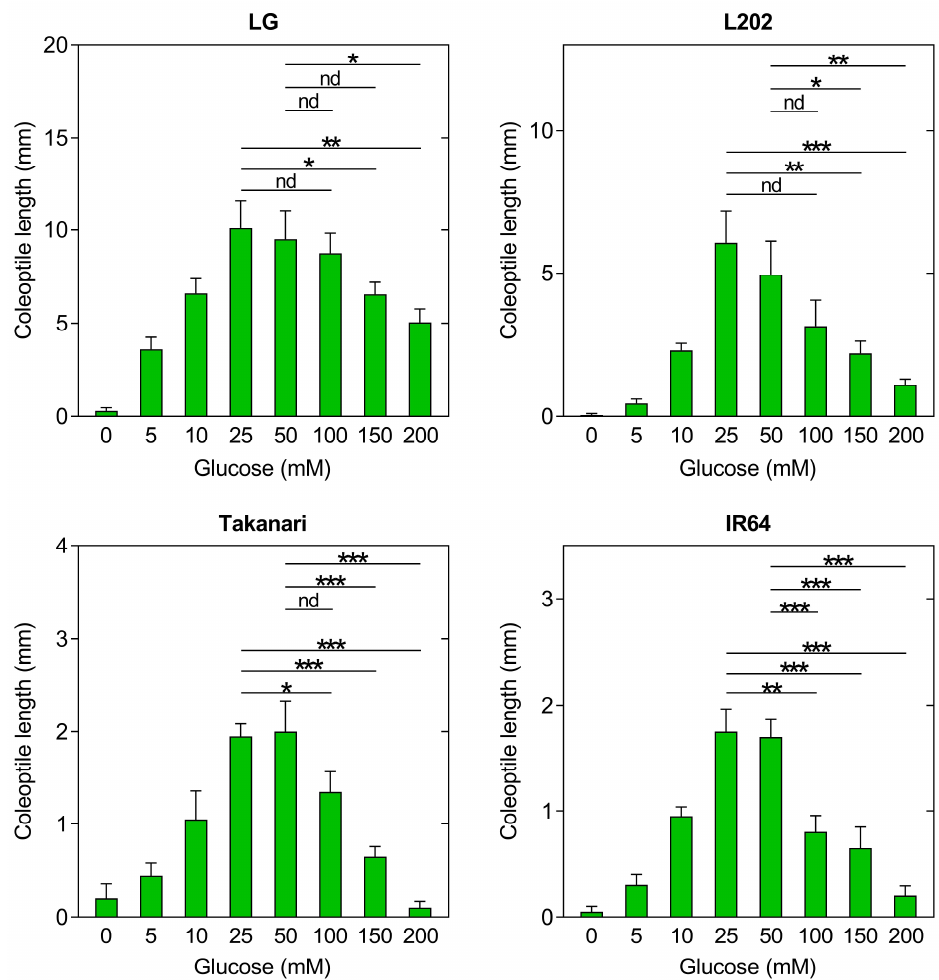
Figure 6. The impact of exogenous glucose on coleoptile elongation under oxygen deprivation in endosperm-less seeds of rice varieties with and without anaerobic germination tolerance. The en- dosperm of each seed was removed and incubated under 12 h light and 12 h dark cycles for 5 days in deoxygenated water containing 0 mM (mock) to 200 mM glucose. Data represent means ± SE ( n = 20). Asterisks indicate a significant difference between two data sets indicated by a line (* p < 0.05, ** p < 0.01, *** p < 0.001; t -test). nd, no significant difference.